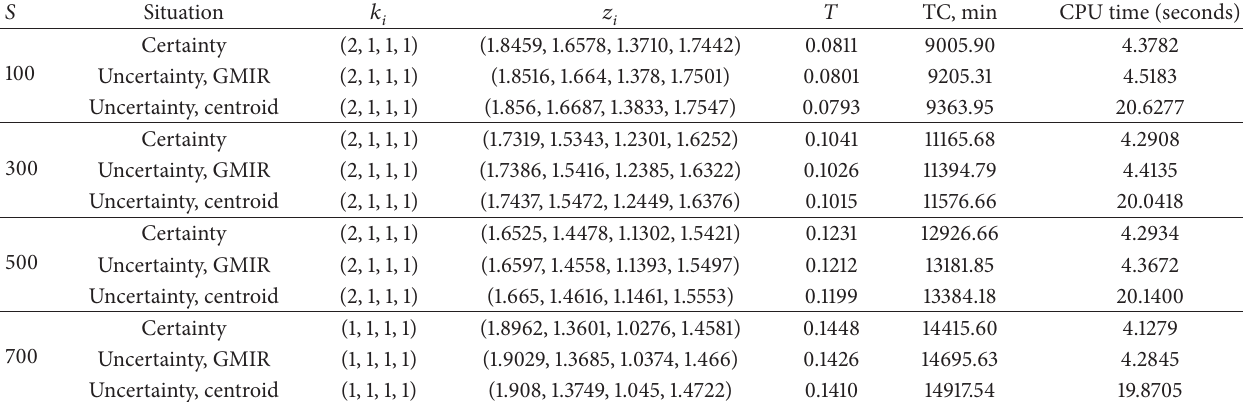
Table 10: Results comparison under different situations after extension (scenarios